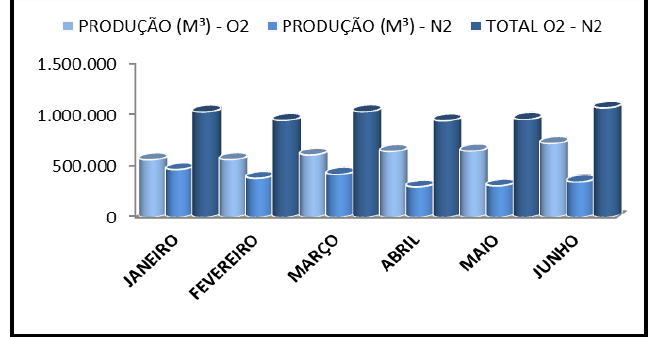
Figura 4. Produção O